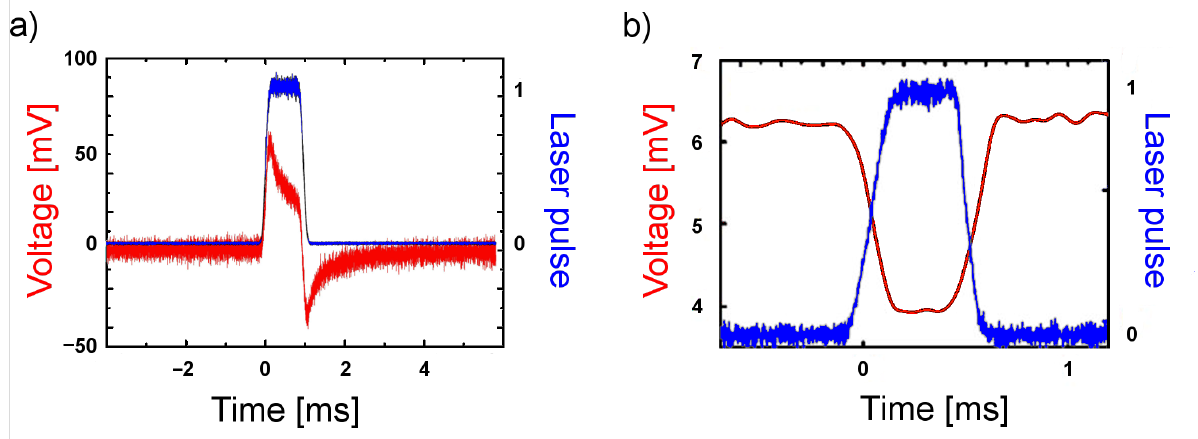
Figure 2: (a) Red: Light-induced signal of a gold electrode under illumination (see Figure 1) in an electrochemical environment. Blue: laser pulse (duration 1 ms). (b) Red: Light-induced signal under illumination of a mechanically controlled break-junction. Blue: laser pulse (duration 0.5 ms) [16].